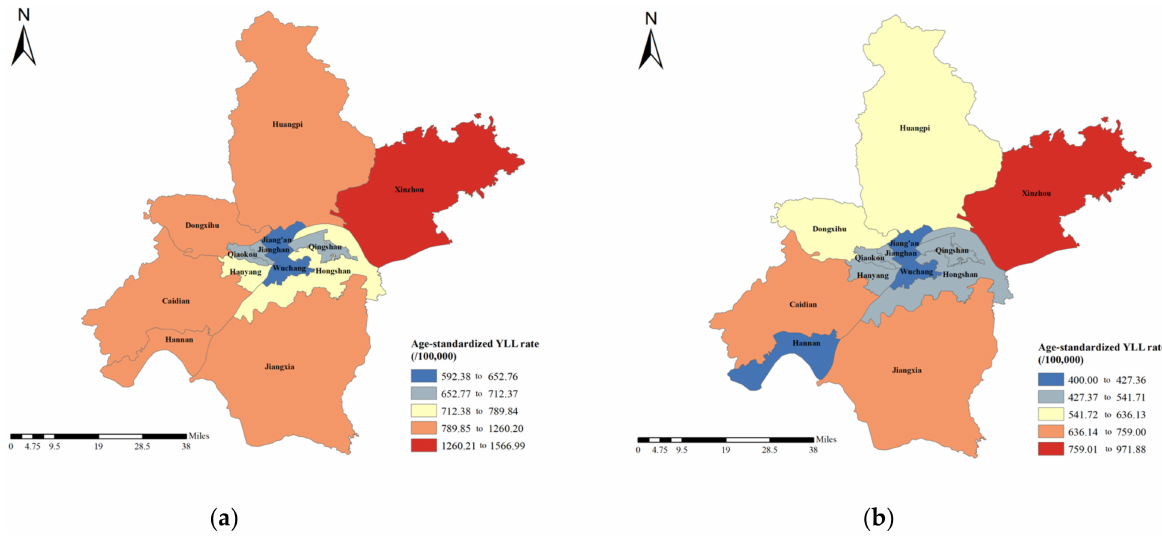
Figure 4. The ASYRs of liver cancer in Wuhan in ( a ) 2010 and ( b ) 2019. The EAPCs of the ASMRs from 2010 to 2019 in Wuhan are shown in Table 1 and Figure 5. The ASMR of liver cancer in Wuhan decreased significantly at an annual rate of 4.23% in men (EAPC = − 4.23, 95% CI: − 4.90 to − 3.55), 5.77% in women (EAPC = − 5.77, 95% CI: − 7.40 to − 4.12) and 4.6% in both sexes (EAPC = − 4.64, 95% CI: − 5.36 to − 3.91) between 2010 and 2019. Huangpi, Hannan, and Xinzhou showed a rapid decline from 2010 to 2019, with EAPCs of − 7.31 (95% CI: − 9.61 to − 4.95), − 7.25 (95% CI: − 10.00 to − 4.41), and − 6.11 (95% CI: − 7.30 to − 4.91), respectively. Most of the districts showed a faster decrease in the ASMRs in women. Table 1. The ASMRs, ASYRs, and EAPCs of liver cancer from 2010 to